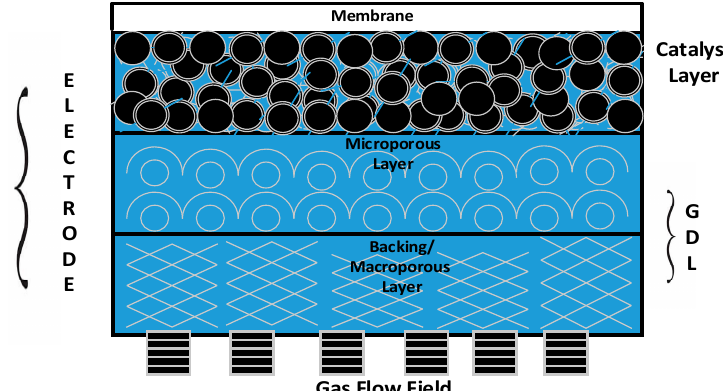
Figure 1. A 2D view of a gas diffusion electrode (GDE) indicating the catalyst layer and gas diffusion layer (GDL; comprising a backing layer and mesoporous layer, MPL).